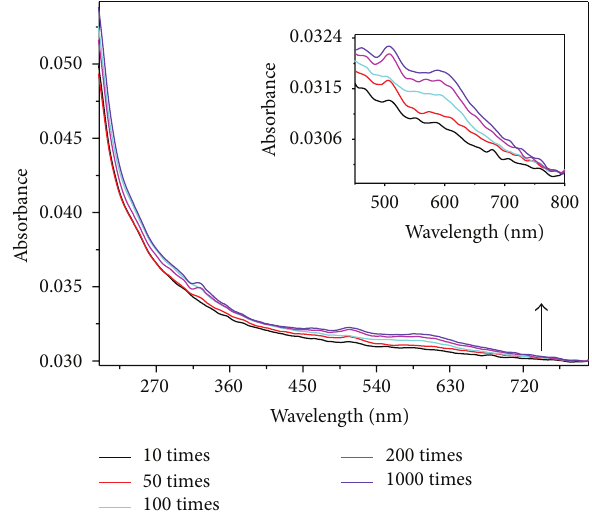
Figure2:Absorptionspectraoffusedsilicapreirradiatedinvacuum by different laser pulses numbers (10, 50, 100, 200, and 1000); the pulse fluence is 8.16 J/cm 2 . The sample exhibits a broad absorption between 500 nm and